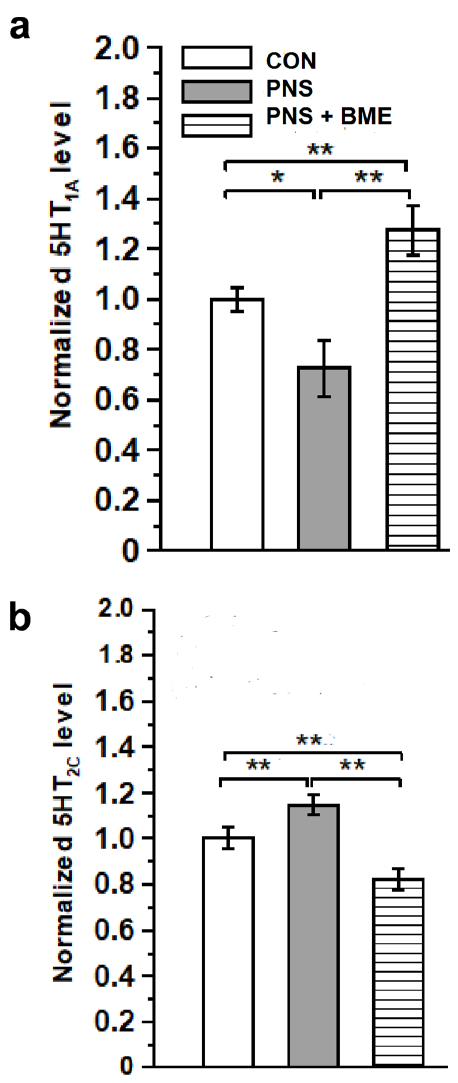
Figure 8. Exposure to BME treatment protects the PNS-induced alternations in the serotonergic system. Quantitative real-time PCR analysis showing that exposure to BME treatment significantly ameliorates the PNS-induced changes in ( a ) 5-HT 1A and ( b ) 5-HT 2C receptor expression. Data are expressed as mean ± SEM ( n = 6 / group). One-way ANOVA followed by Bonferroni post hoc test (for all pairwise multiple comparisons, statistical significance is indicated by * p < 0.05 and ** p < 0.01).